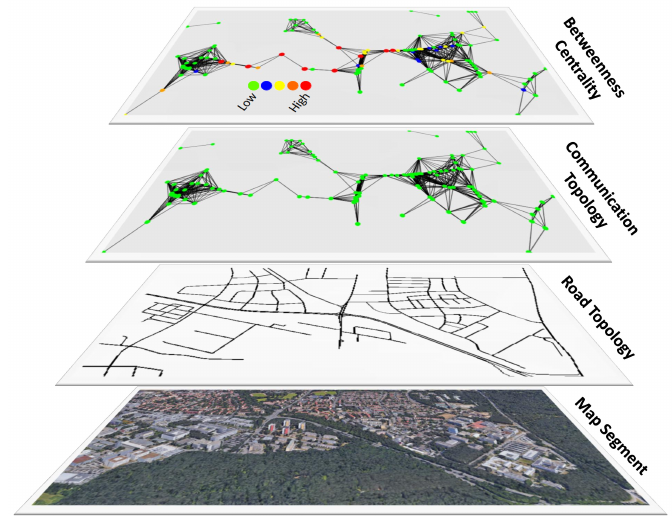
Figure 5. The simulation setup